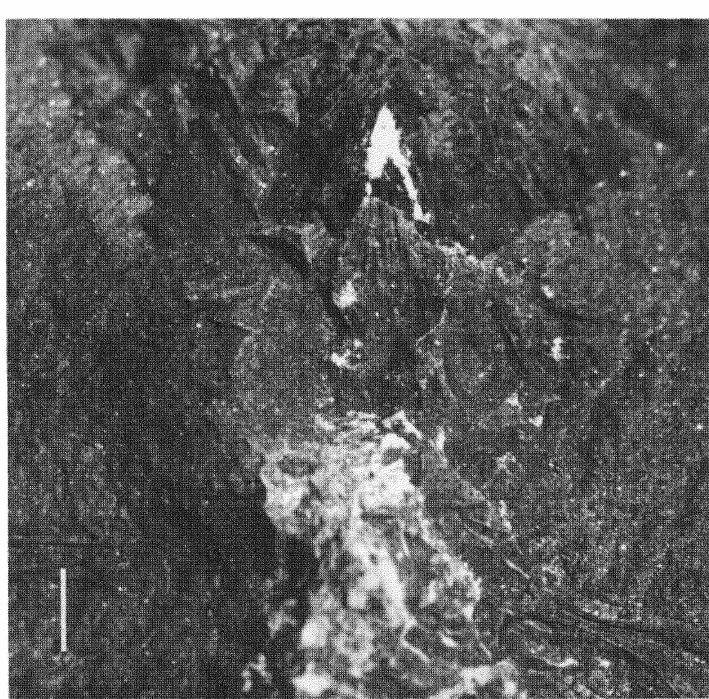
Figure 5. Eubleptus danielsi. Photograph of head of same specimen shown in figure 4, with greater magnification and different illumination. Scale line is mm